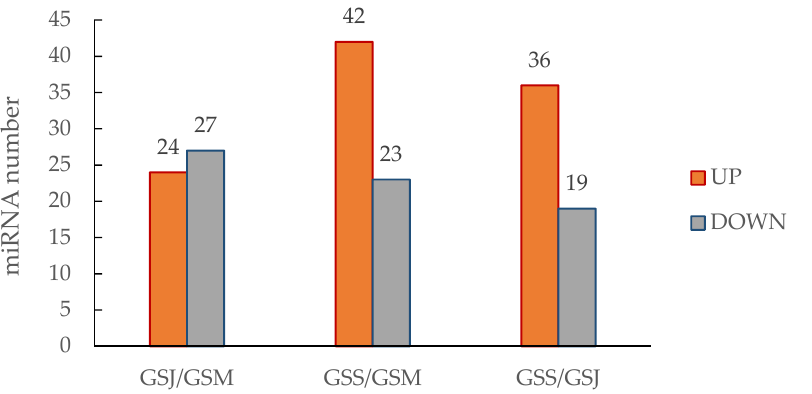
Figure 4. Differentially expressed miRNA numbers in three groups of Gleditsia sinensis pods. Note: